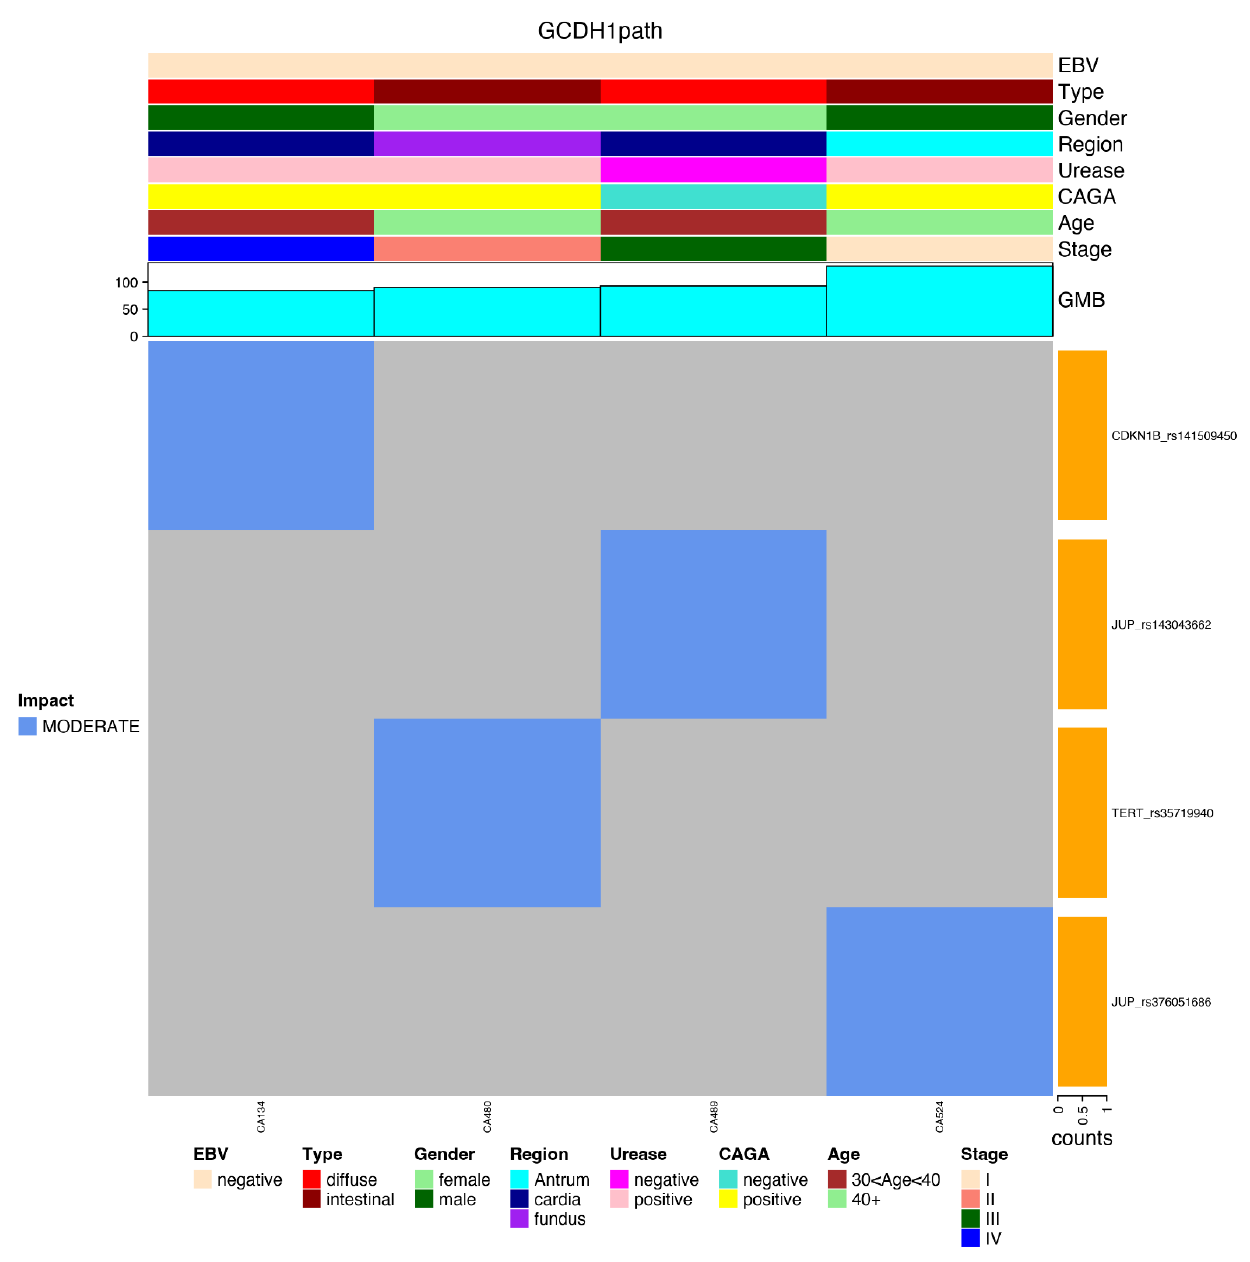
Figure 9. Correlation of most prevalent variants in the GCDH1path gene’s subset among young patients with gastric cancer and their distribution according to clinical features (EBV status, histological type, gender, region of the stomach, urease status, CAGA status, age group and stage), GMB and mutation impact (moderate or high).